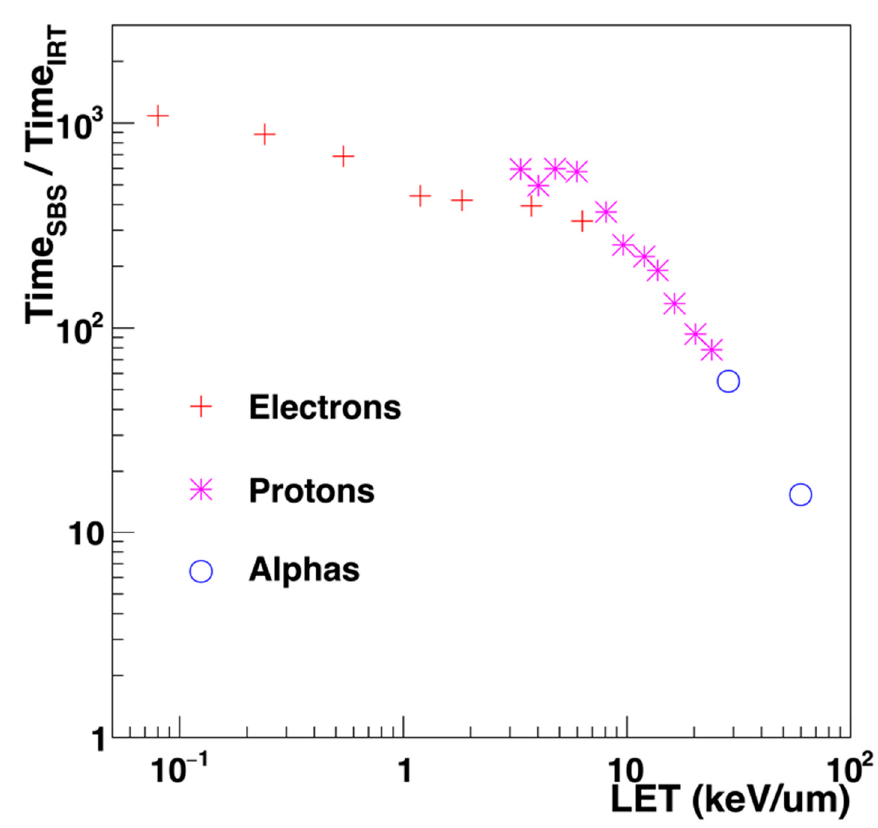
Figure 3. Speedup factor of the SBS approach versus IRT as a function of LET, for electrons, protons, and alphas [106].